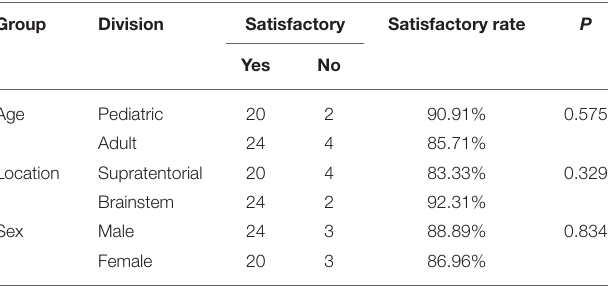
TABLE 3 | Karnofsky performance score of the